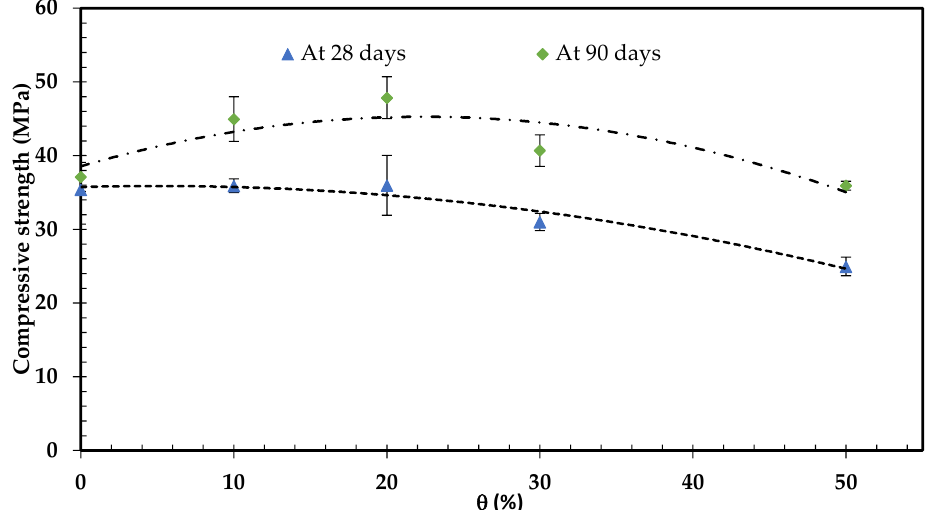
Figure 12. Compressive strength influence of concrete reinforced with different volume percentages of RWG.